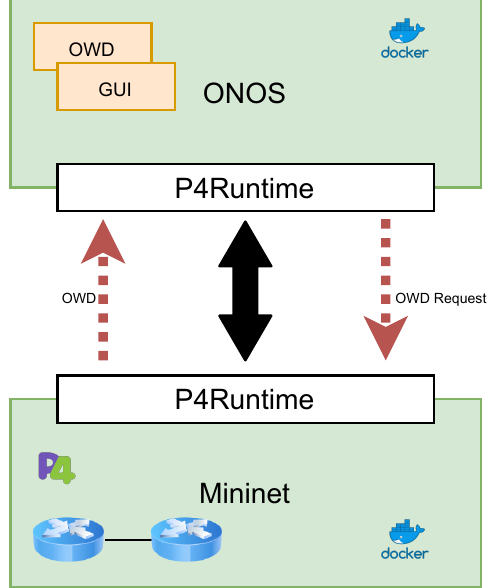
Figure 5. Docker containers infrastructure simulating ONOS-Mininet